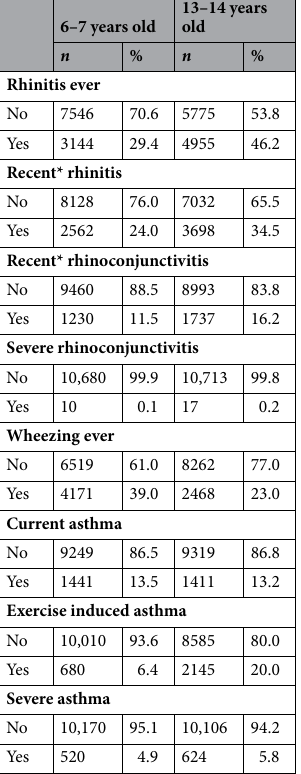
Table 1. Prevalence of rhinitis and asthma symptoms. n : number of cases. *Recent refers to the previous 12